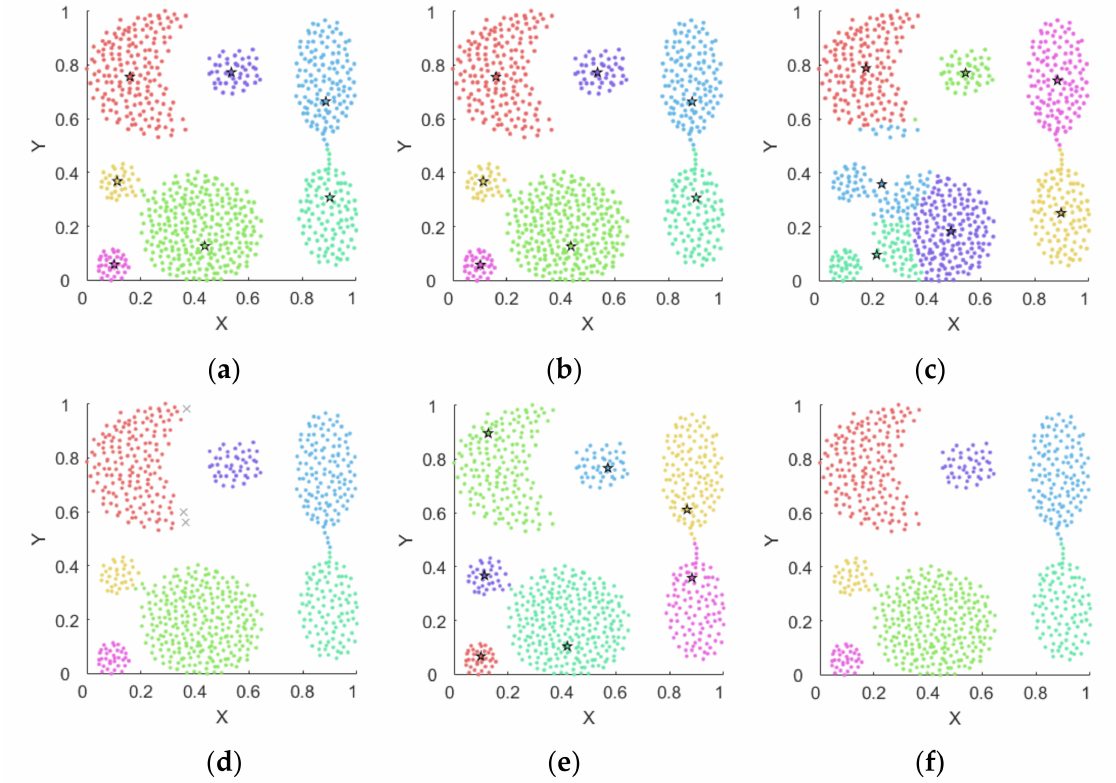
Figure 3. Results on Aggregation. ( a ) ConDPC, ( b ) DPC, ( c ) K-means, ( d ) DBSCAN, ( e ) DPC-DBFN, ( f )